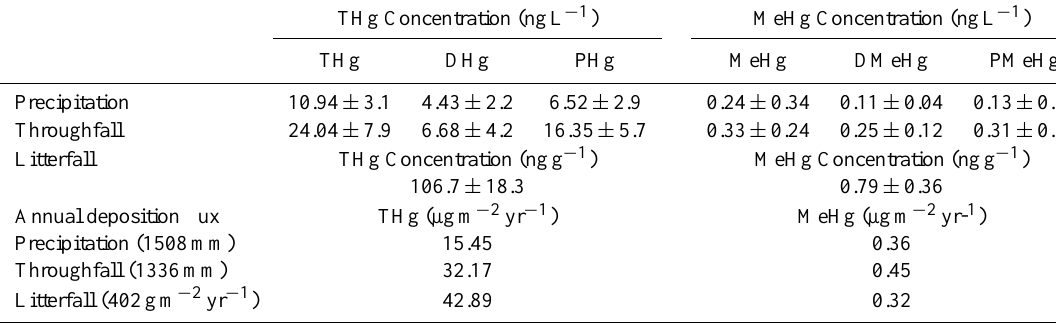
Table 1. Mean values of THg and MeHg concentrations and deposition fluxes in throughfall and